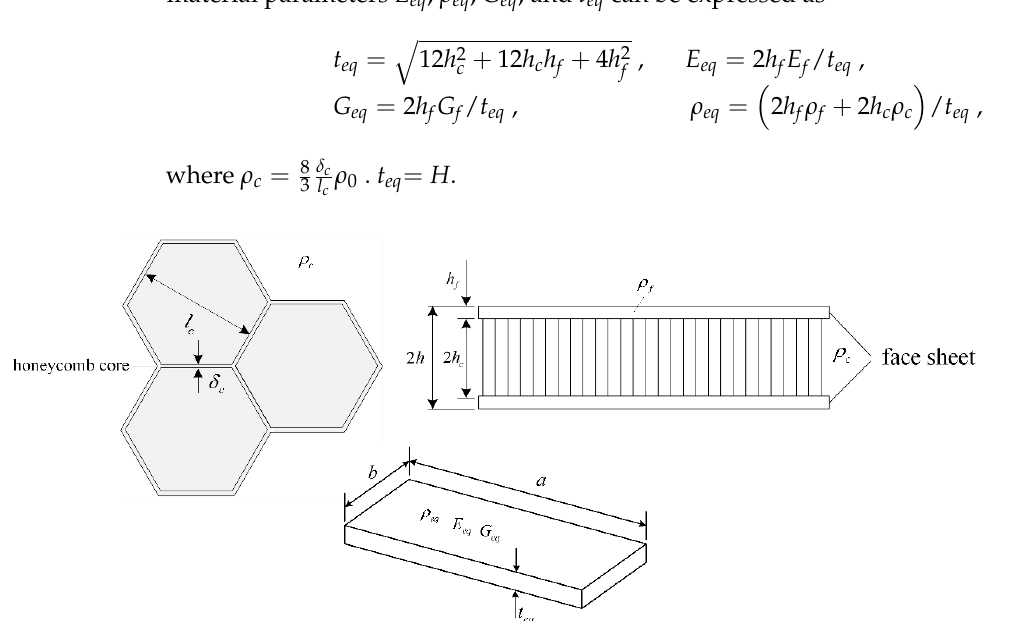
Figure 2. Equivalent isotropic model for the honeycomb sandwich panel. The schematic diagram of the LSFS model and coordinate systems are defined in Figure 3. O 0 - x 0 y 0 z 0 is the inertial reference coordinate system. O - xyz is the floating coordi- nate system on the rigid cube.